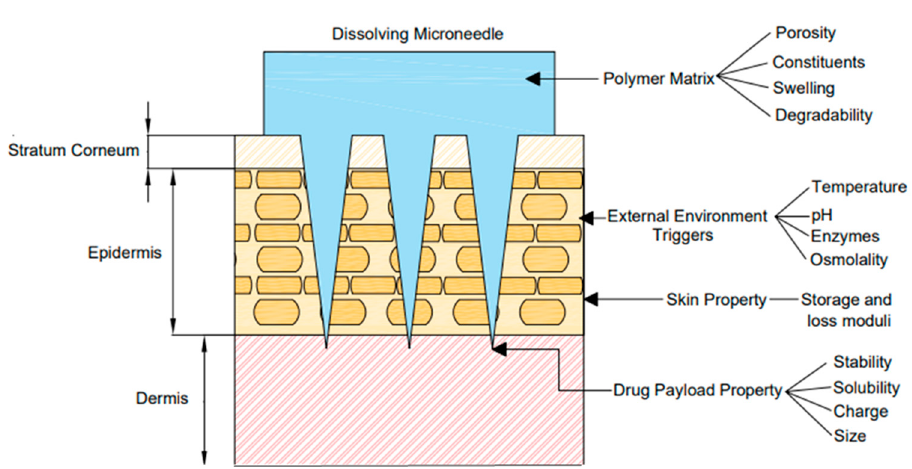
Figure 7. Schematic showing the variables which can affect the rate of drug release from a dissolvable microneedle (adapted from [289]).